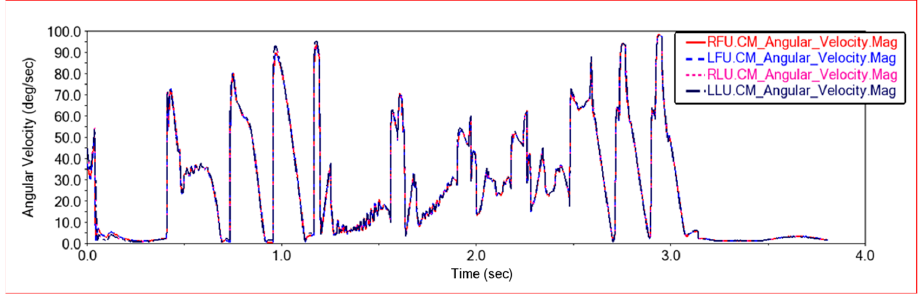
Figure 21. Angular speed comparison curve in Experiment 2. LFU—Front frame upper left joint link, RFU—Front frame upper right joint link, LLU—Rear frame upper left joint link, RLU—Rear frame upper right joint link.